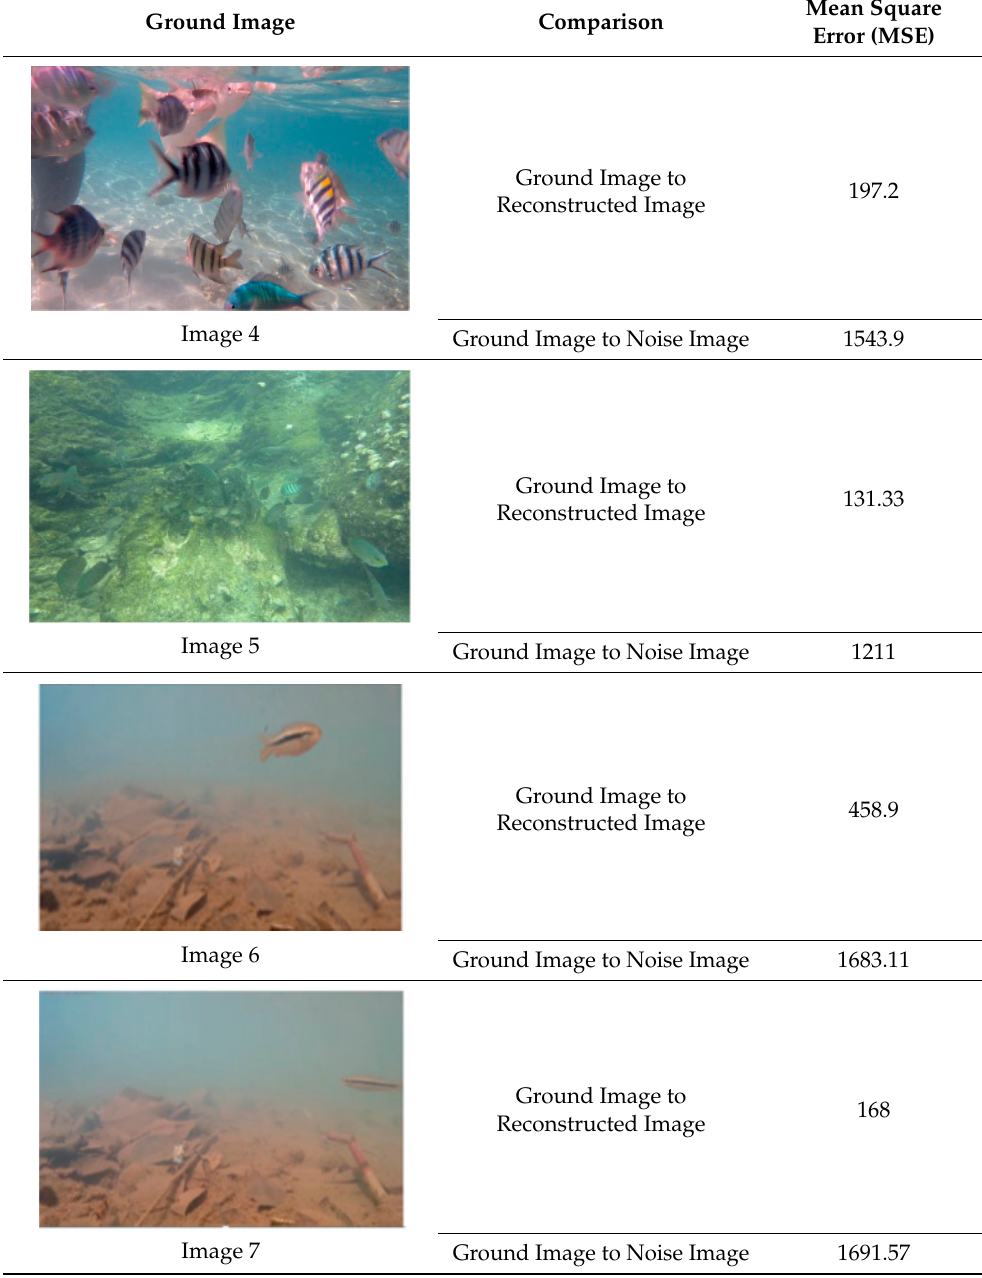
Figure 6. Comparison of MSE of noise and reconstructed images.